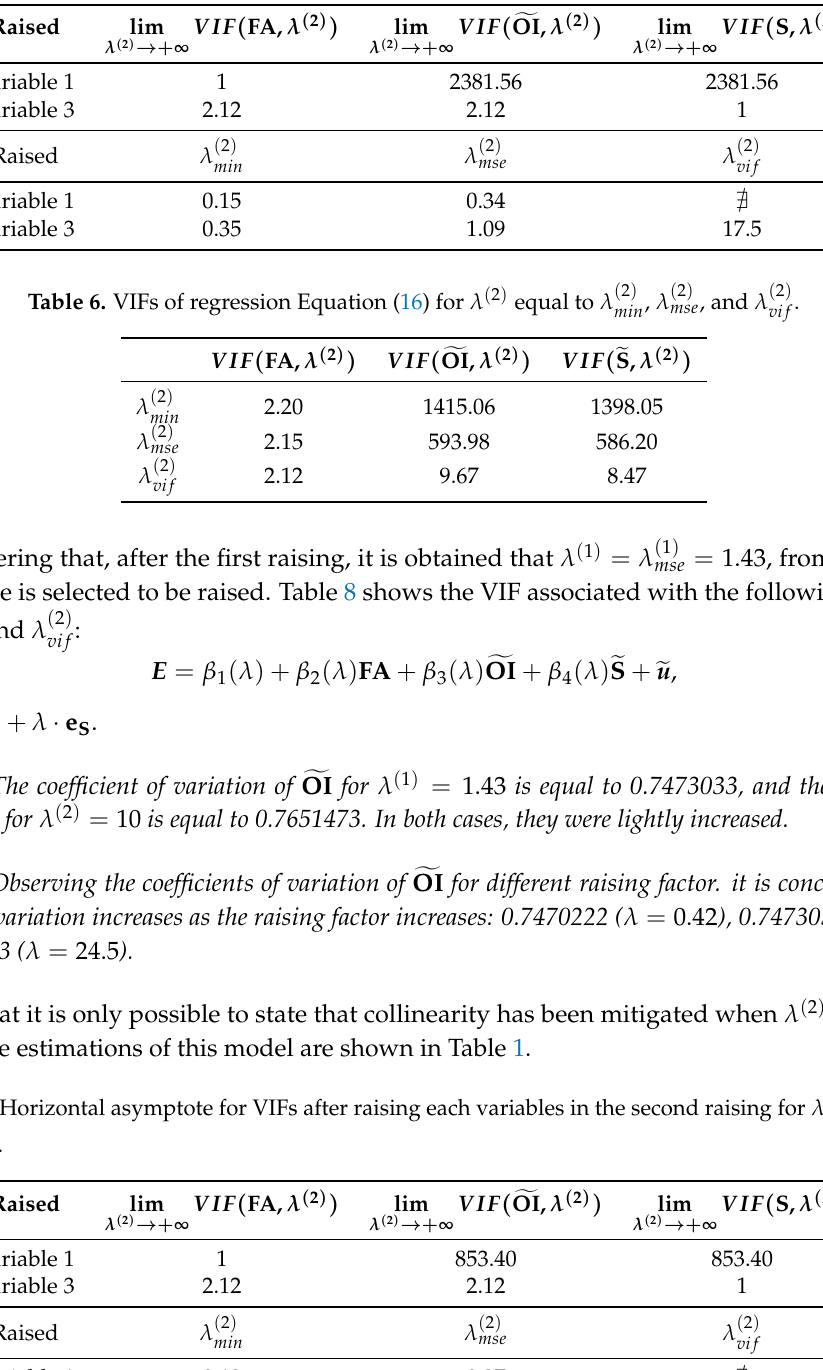
Table 5. Horizontal asymptote for VIFs after raising each variable in the second raising for λ ( 2 ) and λ . vif